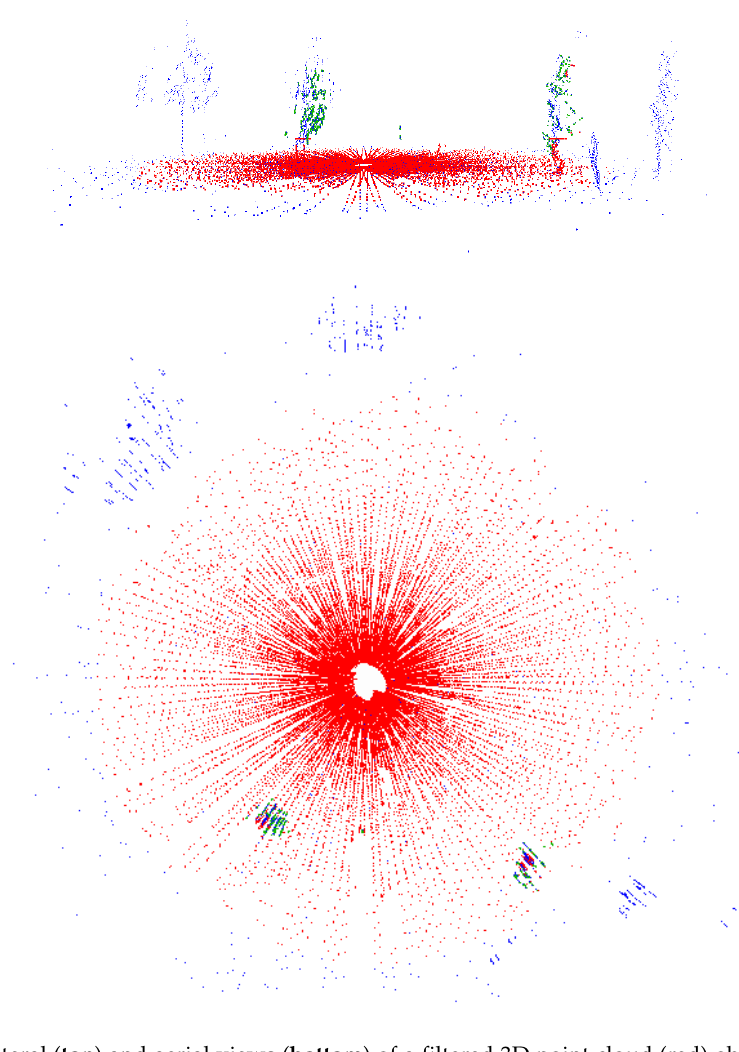
Figure 7. Lateral ( top ) and aerial views ( bottom ) of a filtered 3D point cloud (red) obtained from a leveled 3D point cloud. Blue and green colors represent far points and overhangs, respectively.